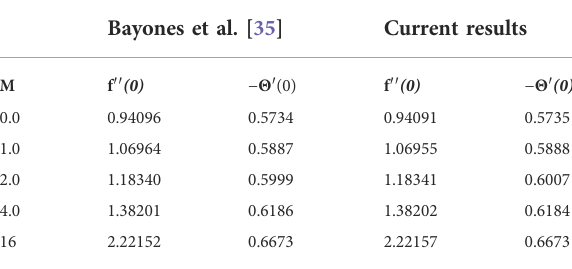
TABLE 3 Numerical evaluations for − Θ 9 (0) and f 99 (0) with fl uctuation in M